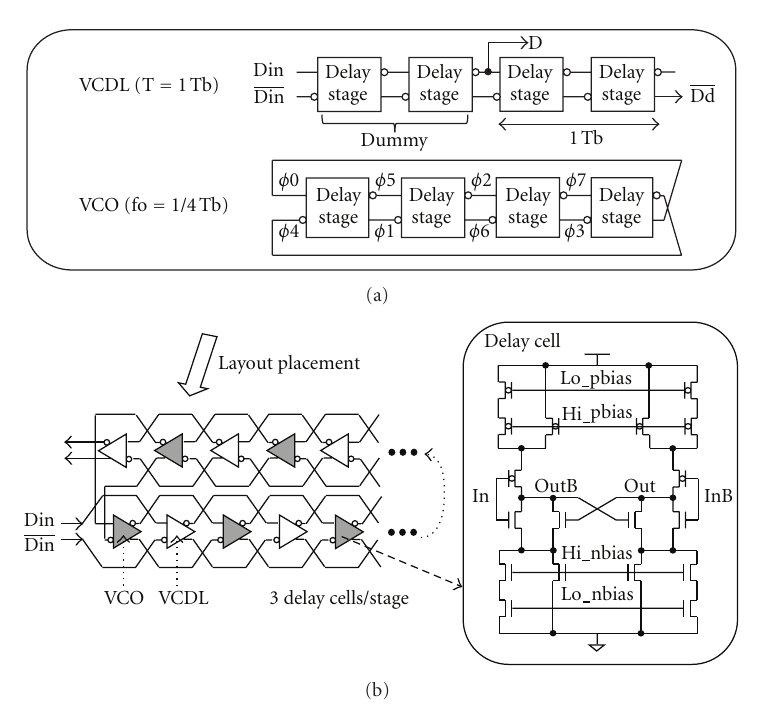
Figure 2: VCDL and